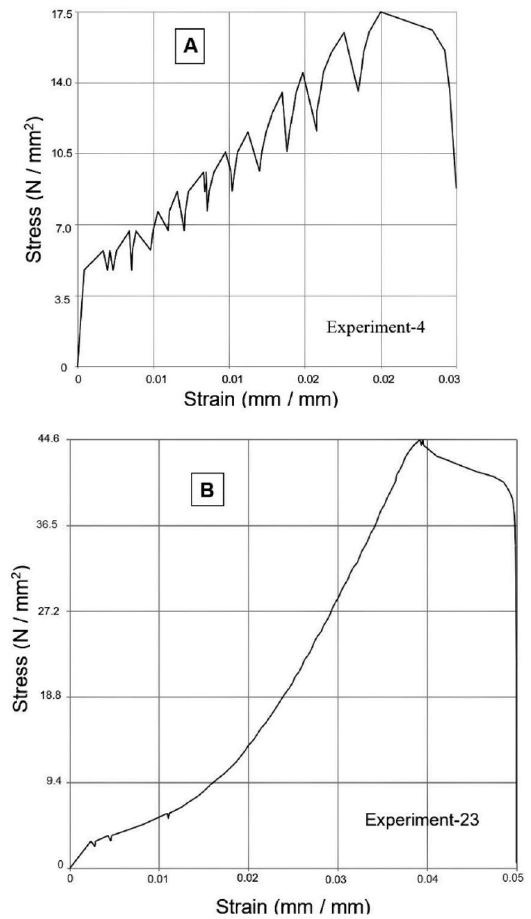
Figure 4 a Stress-strain diagram of Experiment 4 yielding minimum tensile strength, b stress-strain diagram of Experiment 23 yielding maximum tensile strength